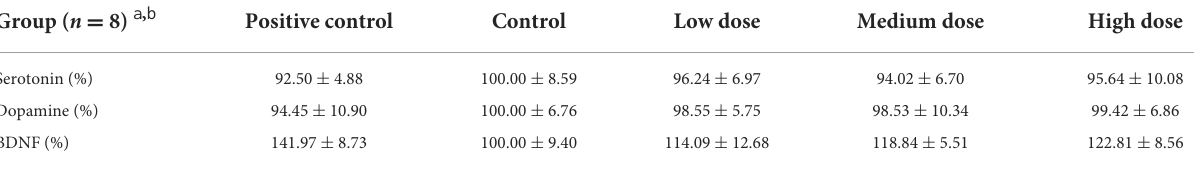
TABLE 4 Effects of combined extracts on the levels of factors correlated to the central nervous system in brain of mice. Group ( n = 8) a ,